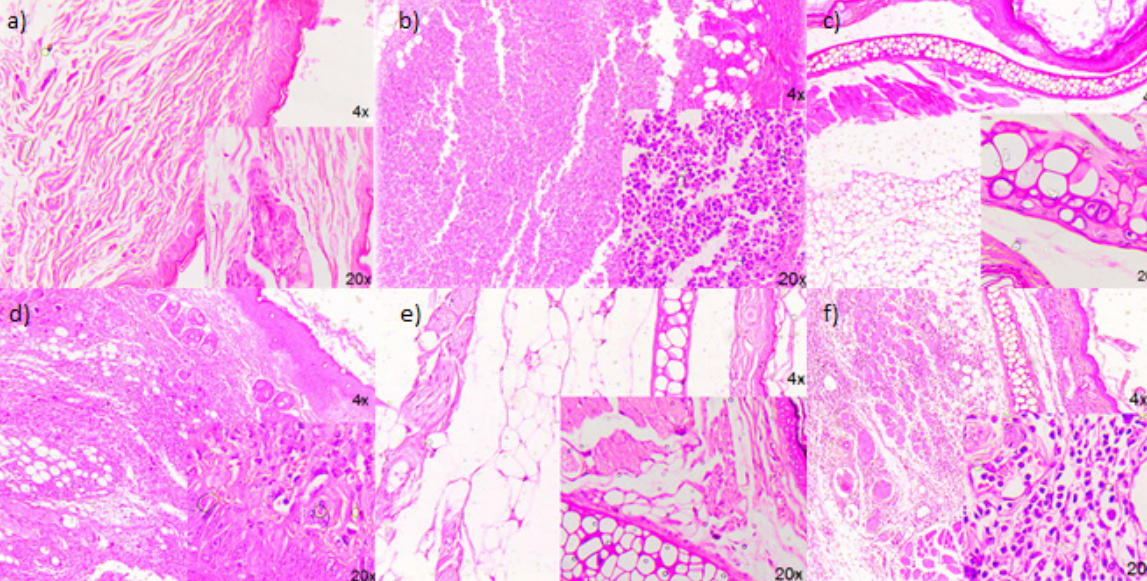
Figure 5. Leukocyte recruitment to the right ear dermis of A / J mice. Mice trained in moderate intensity, high intensity exercise, or the sedentaries, were infected with 10 8 methicillin resistant Staphylococcus aureus (MRSA). Animals were euthanized 72 hours after infection. Animals had excision of the right ear and histopathological slides were analyzed through light microscopy (MRSA: Methicillin-resistant Staphylococcus aureus ) n = 8 to 10. Magnification 20X. a) SC (Sedentary control); b) MIC (Moderate intensity control); c) HIC (High intensity control); d) SI (Sedentary infected); e) MII (Moderate intensity infected); f) HII (High intensity